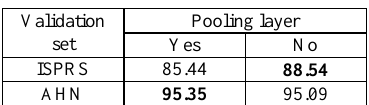
Table 3. Results of employing pooling layer and